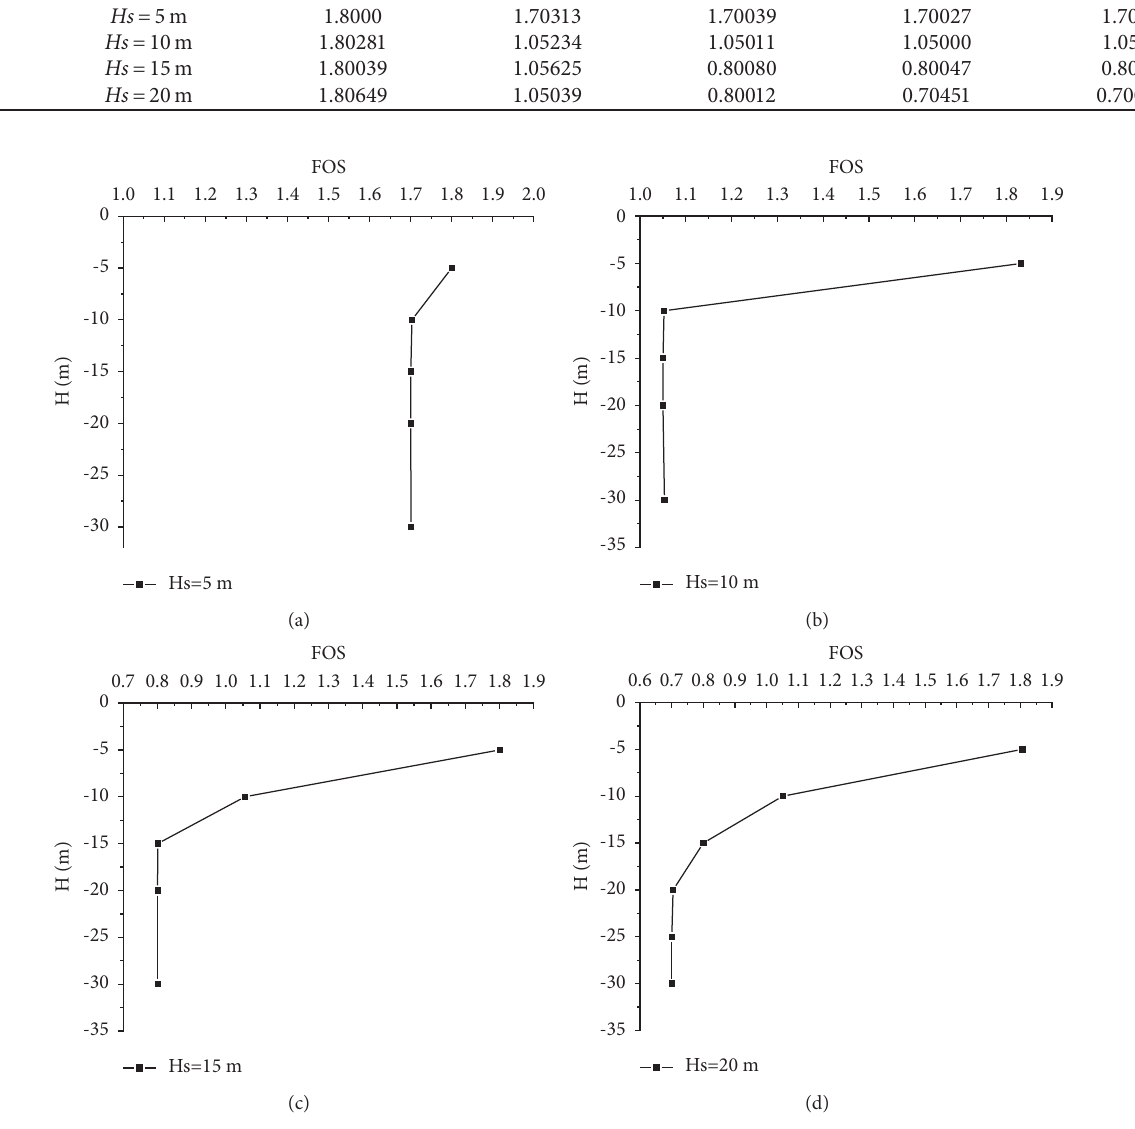
Figure 6: Variation of the foundation pit FOS with excavation depth. (a) Hs � 5 m. (b) Hs � 10m. (c) Hs � 15m. (d) Hs � 20m. Table 3: Classification standard for stable state of foundation pit.